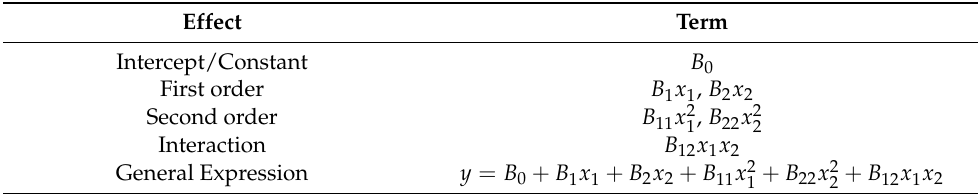
Table 6. General expression of RSM for two independent variables.